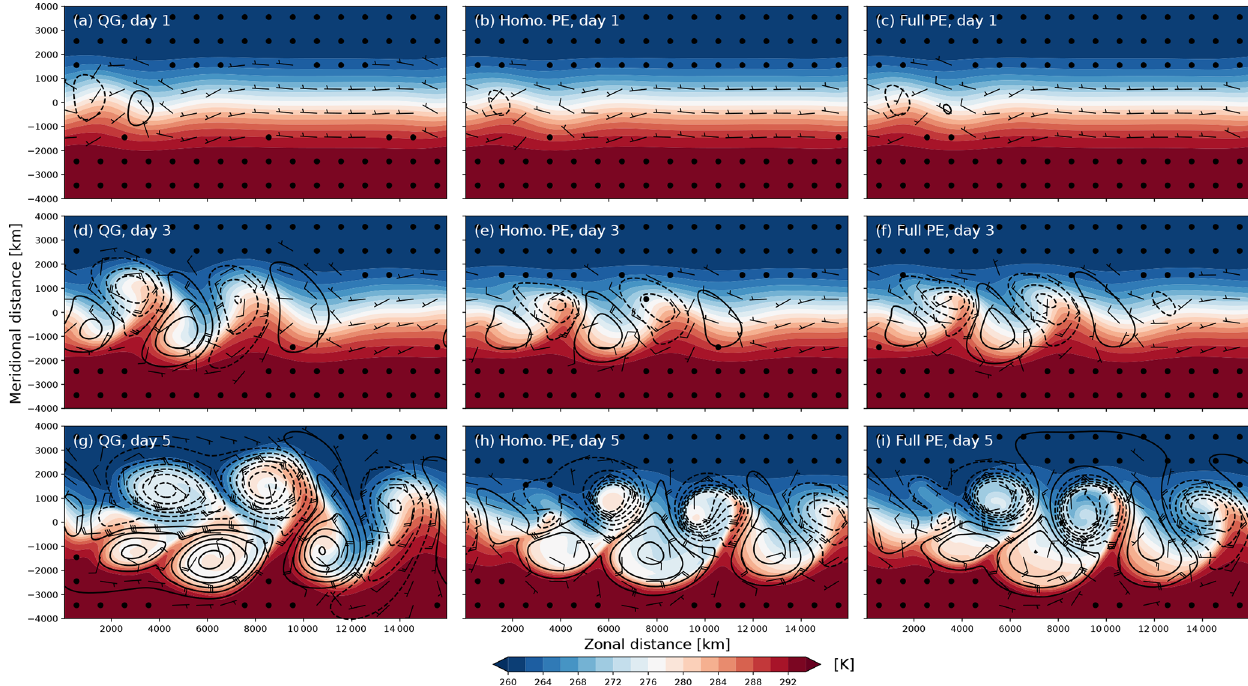
Figure 2. Baroclinic development in a three-layer channel model on an β plane for (a, d, g) QG, (b, e, h) homogeneous-density PE, and (c, f, i) full PE. From top to bottom, the rows show the development after (a–c) 1d, (d–f) 3d, and (g–i) 5d lead time, respectively. The shading shows temperature in Kelvin, and the barbs show the winds (in ms − 1 ), both representing the lowest of the three layers at σ = 5 / 6. The contours show surface pressure with a contour interval of 10hPa centred on 1000hPa, with contours below 1000hPa shown as dashed lines. Note that the entire model domain is not shown in the y